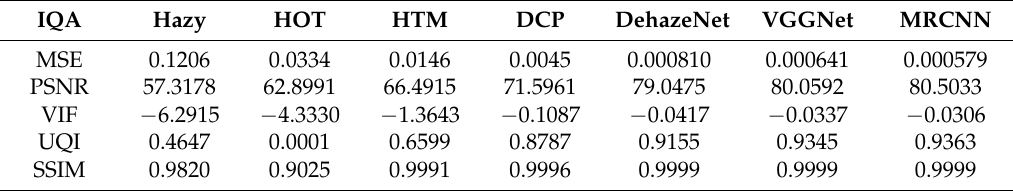
Table 2. Image quality assessment results of dehazed results.